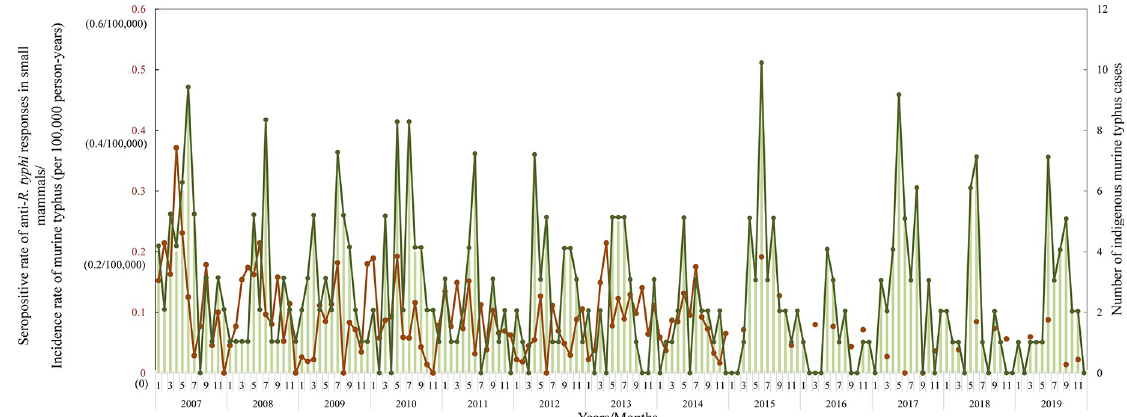
Fig 2. Dynamics of R . typhi infection in small mammals and human cases of indigenous murine typhus from 2007–2019. The seropositive rate of anti- R . typhi responses in small mammals and the incidence rate (per 100,000 person-years) of indigenous murine typhus cases are marked with brown and green, respectively. The numbers of indigenous murine typhus cases are shown as green bars.